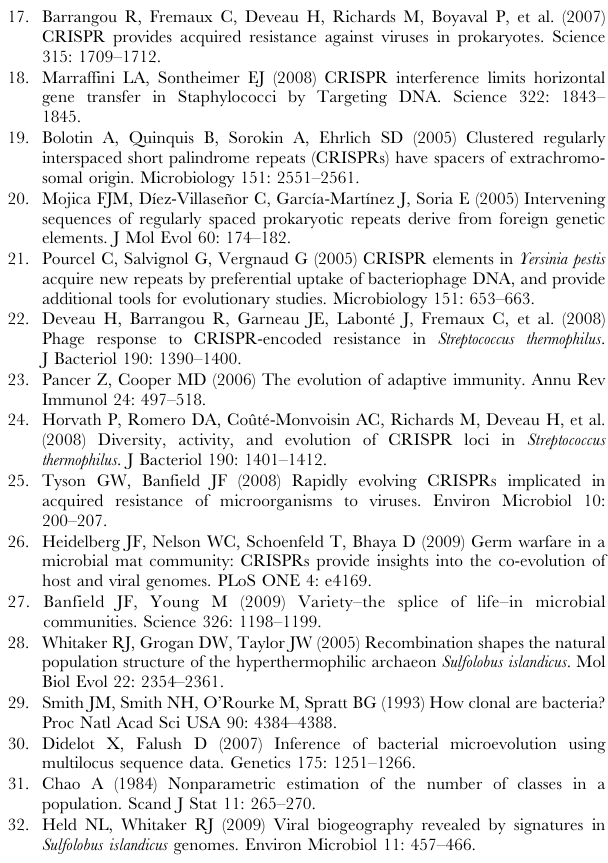
Table S4 MLSA sequence allele accession numbers. Allele numbers for each of the 12 MLSA loci for each strain are shown in the table on the left. Locus marker codes correspond to Table S3. MLSA loci are listed with each allele and accession number in the table on the right. Table S5 CRISPR loci accession numbers. Accession numbers for CRISPRs are listed by strain and locus. The first number at each locus corresponds to the leader end sequence and the second number corresponds to the trailer end. ‘NA’ and ‘X’ as in Figure 1. The CRISPR_id from the CRISPRdb website [50] is shown for M.16.27 and